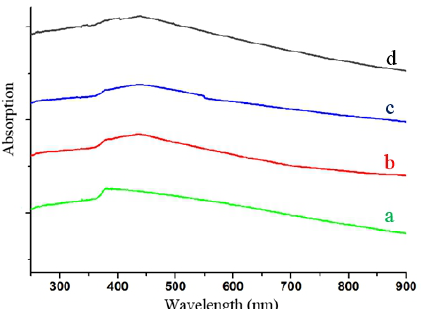
Fig. 4. Spectra of nanoparticles a) ZnO b) WO-ZnO 0.5% c) WO-ZnO 1% d) WO-ZnO 2%